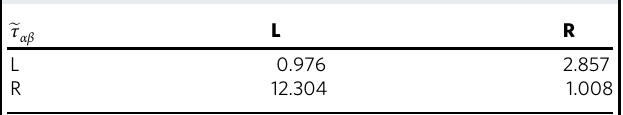
Table 1 Normalised class mean fi rst massage times (CMFPT) between constituencies that voted for Leave (L) or Remain (R) in the Brexit referendum if the class assignment is done according to the option with the majority of the